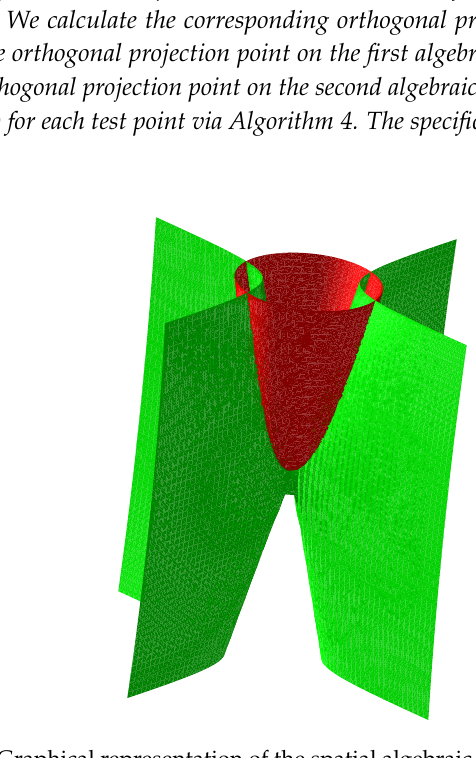
Figure 7. Graphical representation of the spatial algebraic curve for Example